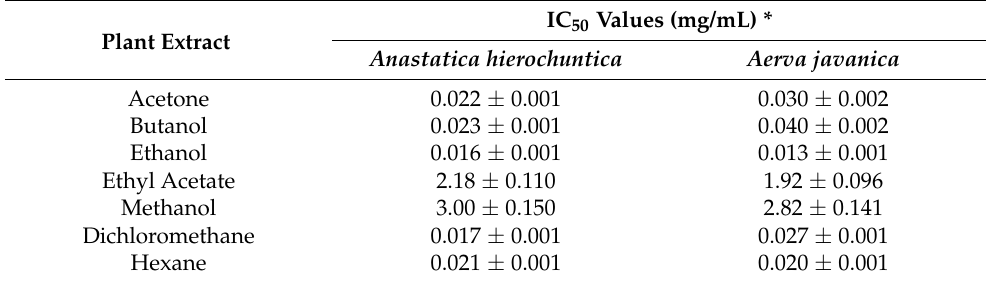
Table 4. Antioxidant activities of Anastatica hierochuntica and Aerva javanica IC 50 values (mg/mL).